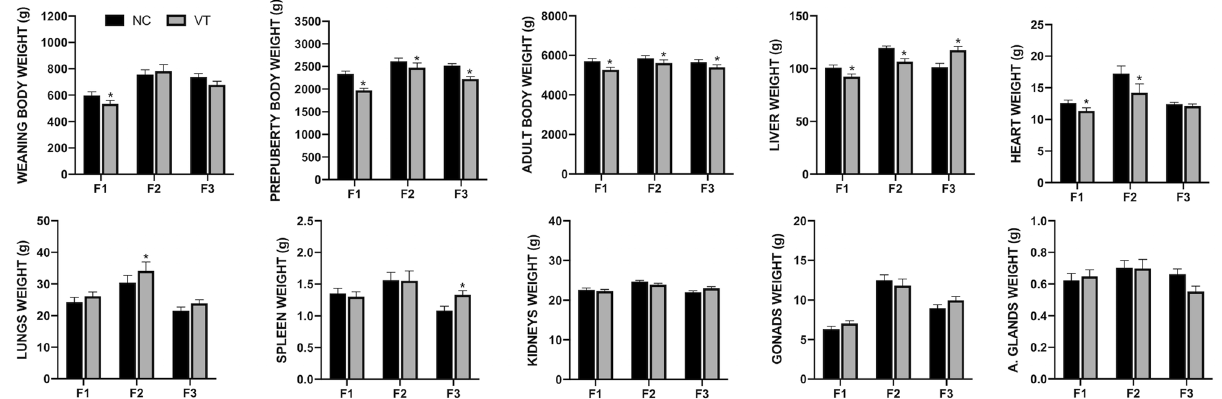
Figure 2. Differences in phenotypic traits between naturally-conceived (NC) and vitrified-transferred (VT) progenies during three generations (F1, F2, F3). Asterisks denote relevant differences between VT animals and their NC counterparts (Bayesian inference: |D NC-VT |> R and P 0 > 0.8; Supplementary Table